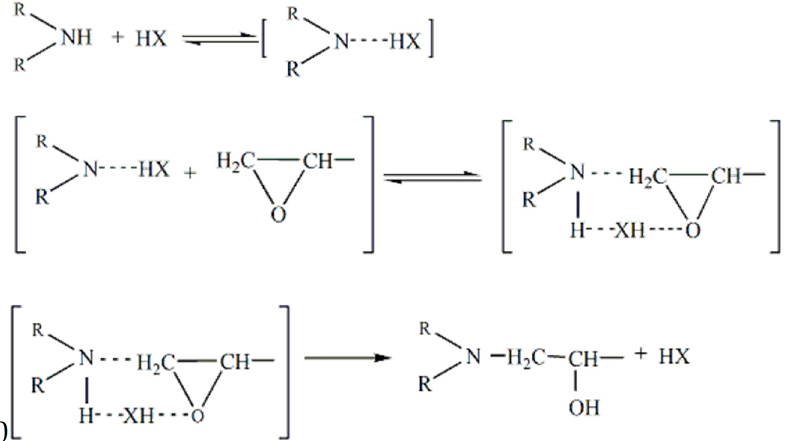
Figure 8. Schematic illustration of a trimolecular transition state amine–epoxy–hydroxyl.